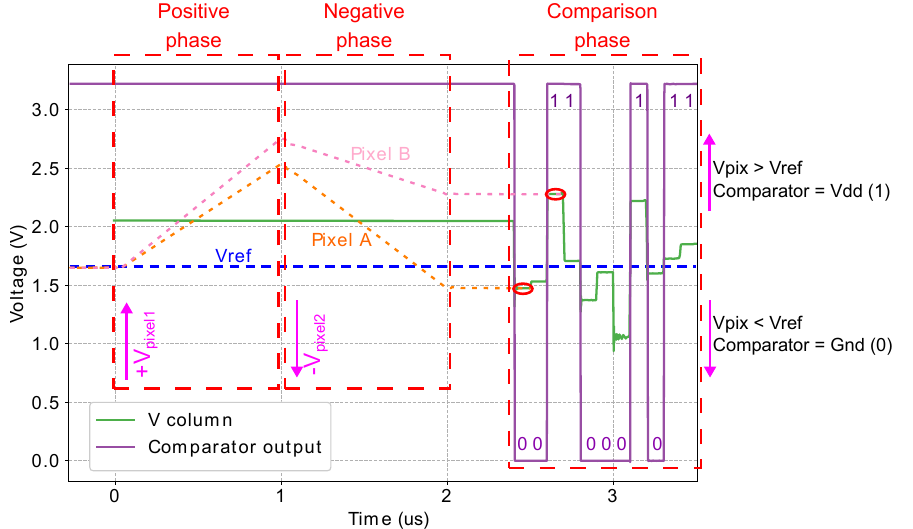
Figure 17. Postlayout simulation of the RPG input comparator while reading multiple pixels. The plot shows the integration phase for the first and third pixel, the voltage input to the comparator, the reference voltage, and the voltage output. Gradient values are read every 50